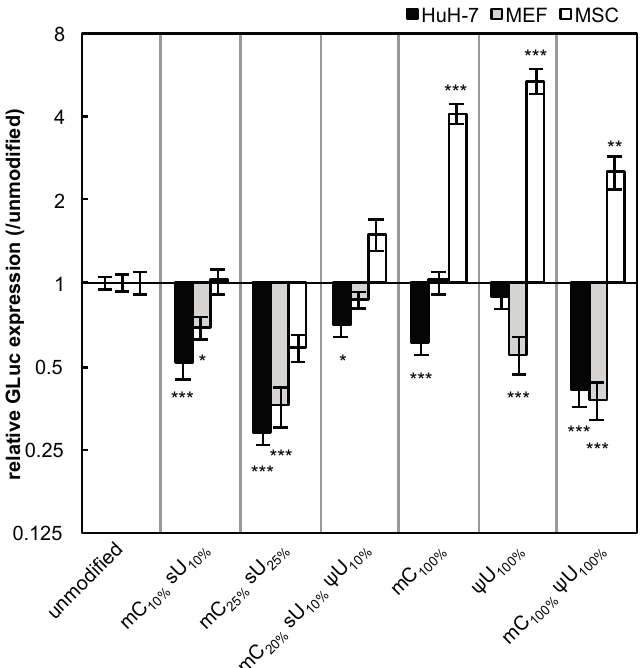
Figure 3. GLuc expression in HuH-7 cells, MEFs, and MSCs. mRNA-encoding GLuc was introduced to HuH-7 cells (black bars), MEFs (gray bars), and MSCs (white bars) using Lipofectamine™ LTX. After 24 h, the amount of GLuc protein in culture media was measured. The graph shows relative values compared to GLuc expression after transfection of unmodified mRNA. Data are presented as the mean ± standard error of the mean (S.E.M.) ( N = 6). Statistical significance was assessed by one-way analysis of variance (ANOVA) followed by Dunnett’s test. * p < 0.05, ** p < 0.01, *** p < 0.001 versus unmodified